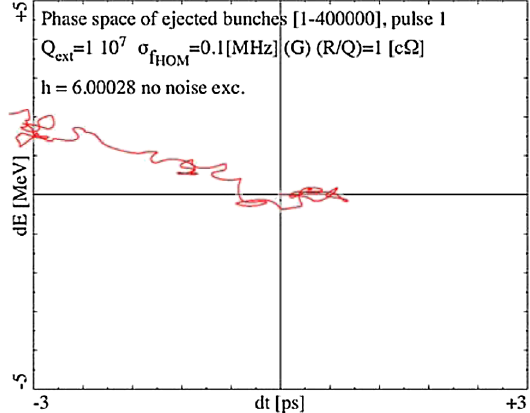
FIG. 44. (Color) Phase-space image of the ejected bunches of the second pulse. Conditions as Fig. 43 but Q ext ¼ 10 7 .